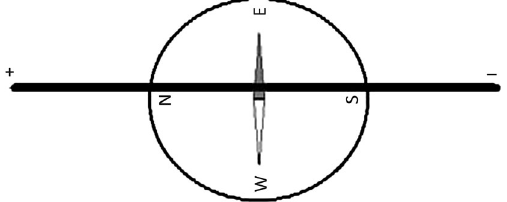
FIG. 1. Experiment 1: the Oersted experiment. A wire was placed above the compass and current was then switched on.